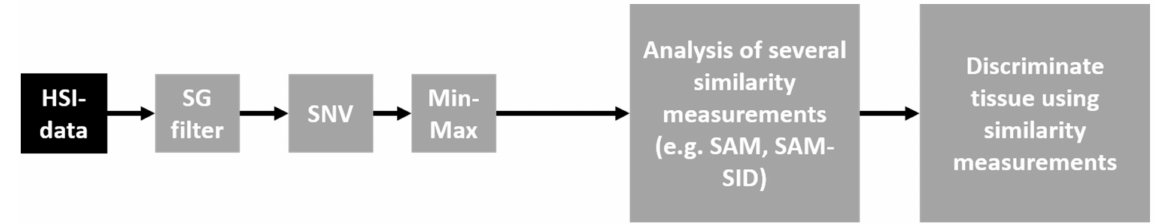
Figure 1. Pipeline of the overall